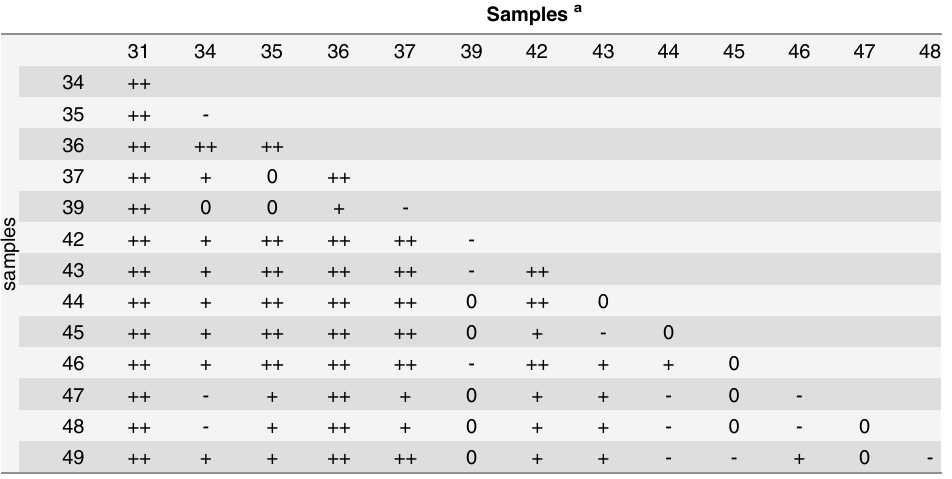
a Sample 31 came from a hotel. Samples 34 – 49 came from the same apartment building. “ ++ ” denotes two highly differentiated sample collections at a p -value < 10 − 7 ; “ + ” denotes two sample collections differentiated at a p -value < 0.01; “ - ” denotes two sample collections that are not signi fi cantly differentiated at a p -value > 0.01; and “ 0 ” denotes two identical populations at a p -value >